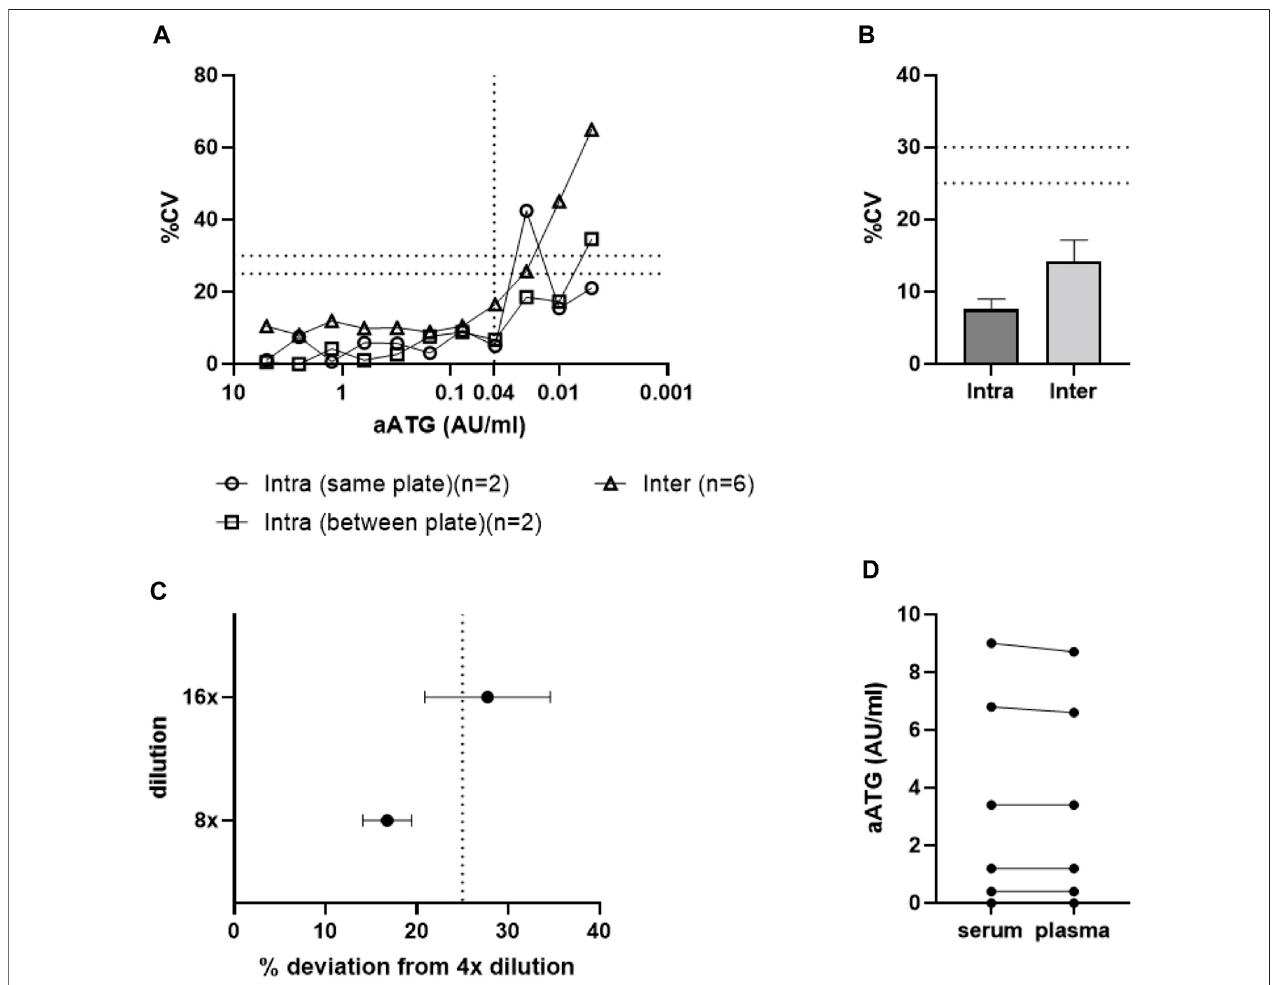
FIGURE4| ActiveATGbindingassayvalidation.GraphAandBshowresultsforassayaccuracyandprecisionexpressedin%CV.ResultsareshownforIntra-and inter-assay variability results of (A) standard curve samples and (B) patient samples (data shown as mean +SEM). The LLoQ was set at 0.04 AU/ml (A) . Graph (C) demonstrates that high patient sample dilutions (16-fold) show increased deviation above the threshold of 25% and should therefore be excluded from analysis (data shown as mean ± SEM). Dashed lines in graphs (A – C) represent maximal acceptable assay/sample variability expressed in %CV. Graph (D) demonstrates that both plasma and serum samples from the same patient show similar results in the aATG binding assay and can therefore both be used for analysis.